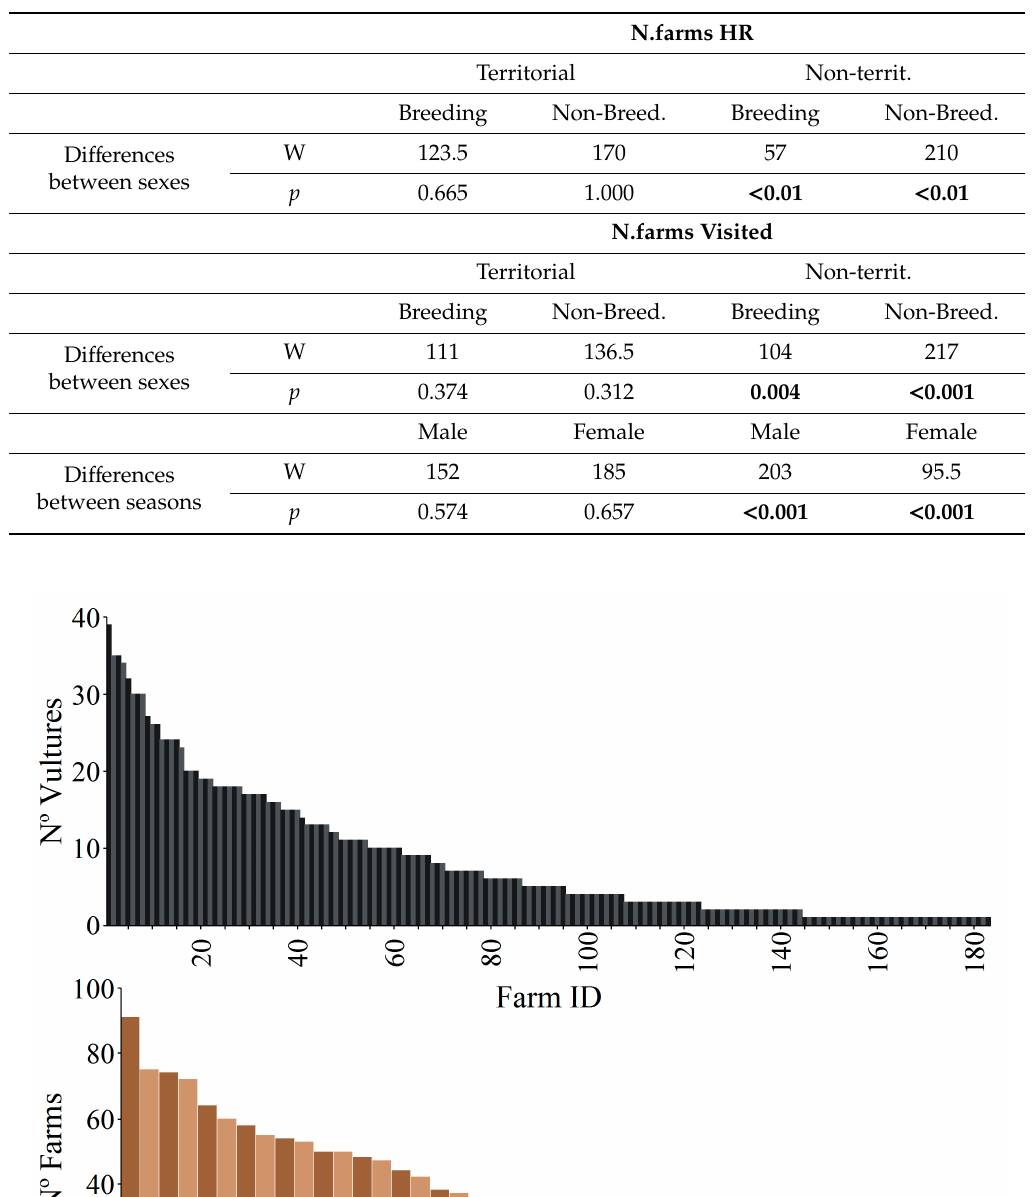
Table 3. Results from Mann–Whitney U-tests assessing differences between sexes and breeding seasons in the number of farms included in Egyptian Vultures’ home ranges (N.farms HR) and in the number of farms visited by vultures (N.farms visited) accounting for their territorial status. Significant differences are bolded.